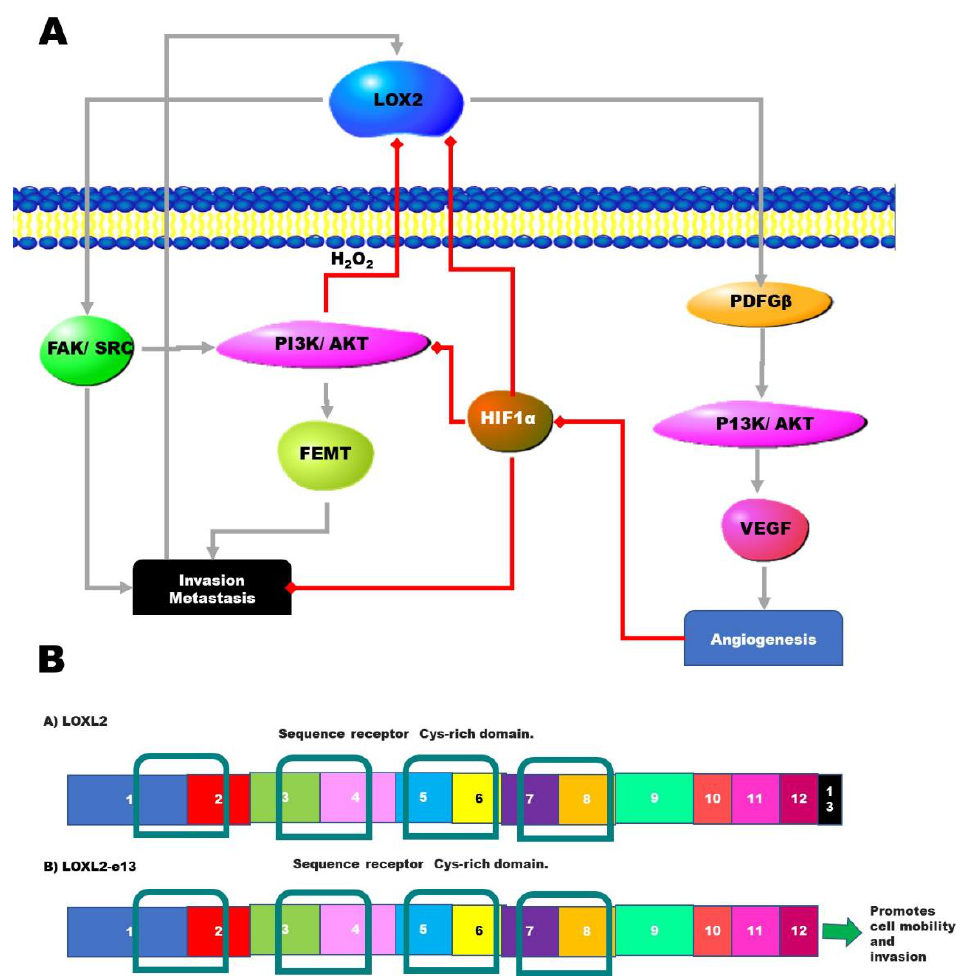
Figure 3. Alternate splicing of the LOXL2 mRNA. ( A ) The lysyl oxidase-like (LOXL2) signaling pathway stimulates invasion and angiogenesis in cancer cells. The pathway is also inhibited because of hypoxia. Green lines with green arrows indicate stimulation or induction, while red lines with red diamonds indicate inhibition. ( B ) The e13 splice variant of LOXL2 results from the exclusion of the final exon, exon 13. This variant promotes stronger signaling promoting invasion and metastasis. Both isoforms contain all four SR domains (scavenger receptor Cys-rich domain). These are shown in the figure as the blue boxes. These domains are responsible for facilitating binding to cell membranes during phagocytosis. FAK, focal adhesion kinase; PI3K/AKT, phosphatidylinositol 3-kinase/protein kinase B; HIF1 α , hypoxia-inducible factor 1 α ; VEGF, vascular endothelial growth factor; EMT, epithelial-mesenchymal